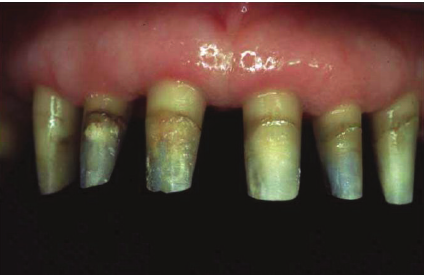
Figure 12: Alveolar bone removal was done until a positive archi- tecture was reached.